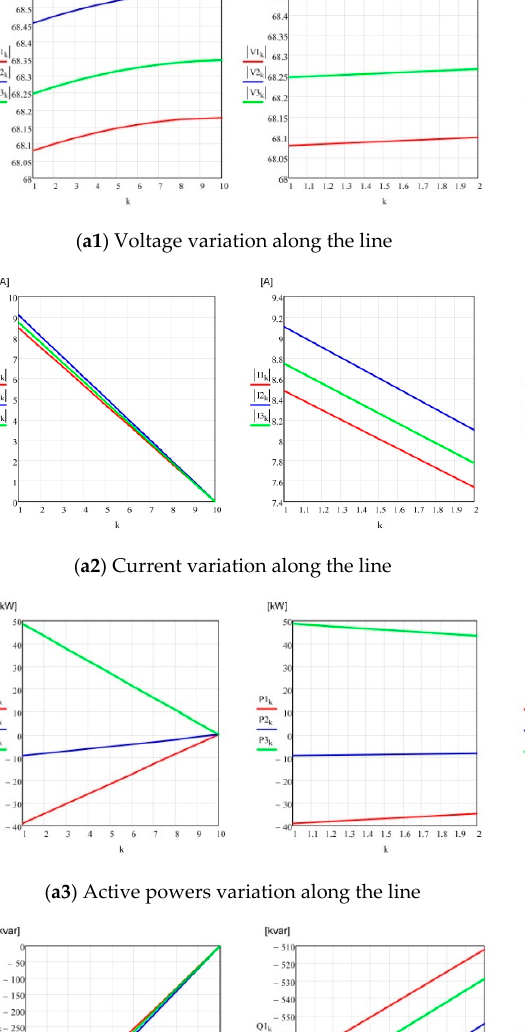
Only the values calculated for Section 1 can be compared to those measured. Therefore, in the numerical study carried out for both the untransposed line and the transposed version, we aimed to obtain values for the voltages as close as possible to the measured values and to their average value, respectively. From the set of recorded values, the ones from 2 October 2018 13:01:19 ’584 were retained, corresponding to a very short period in which the operating regime was quasi-stationary.